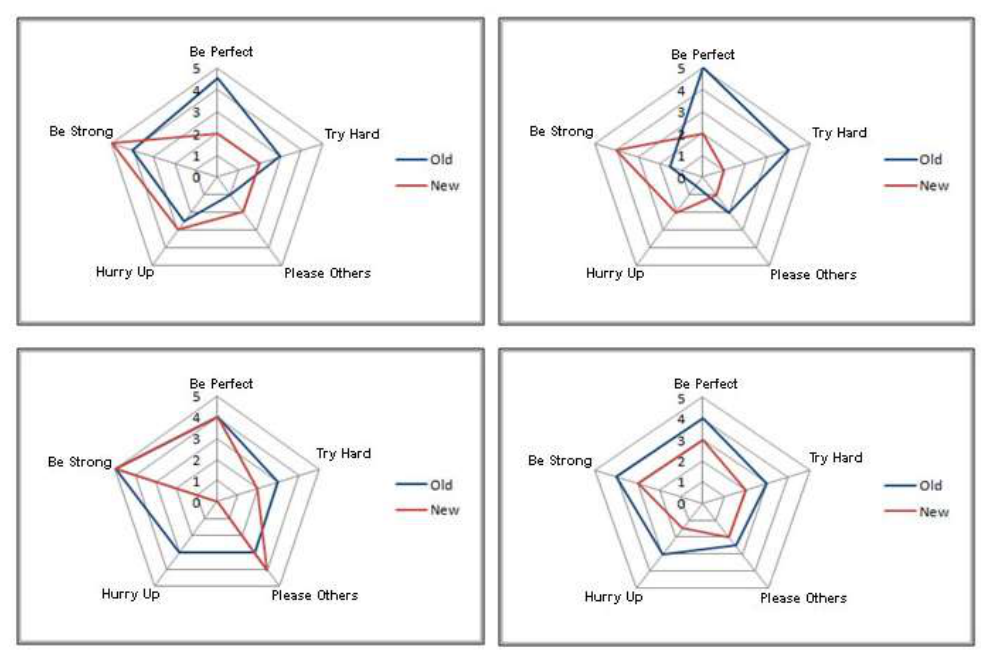
Figure 9: Examples of particular changes